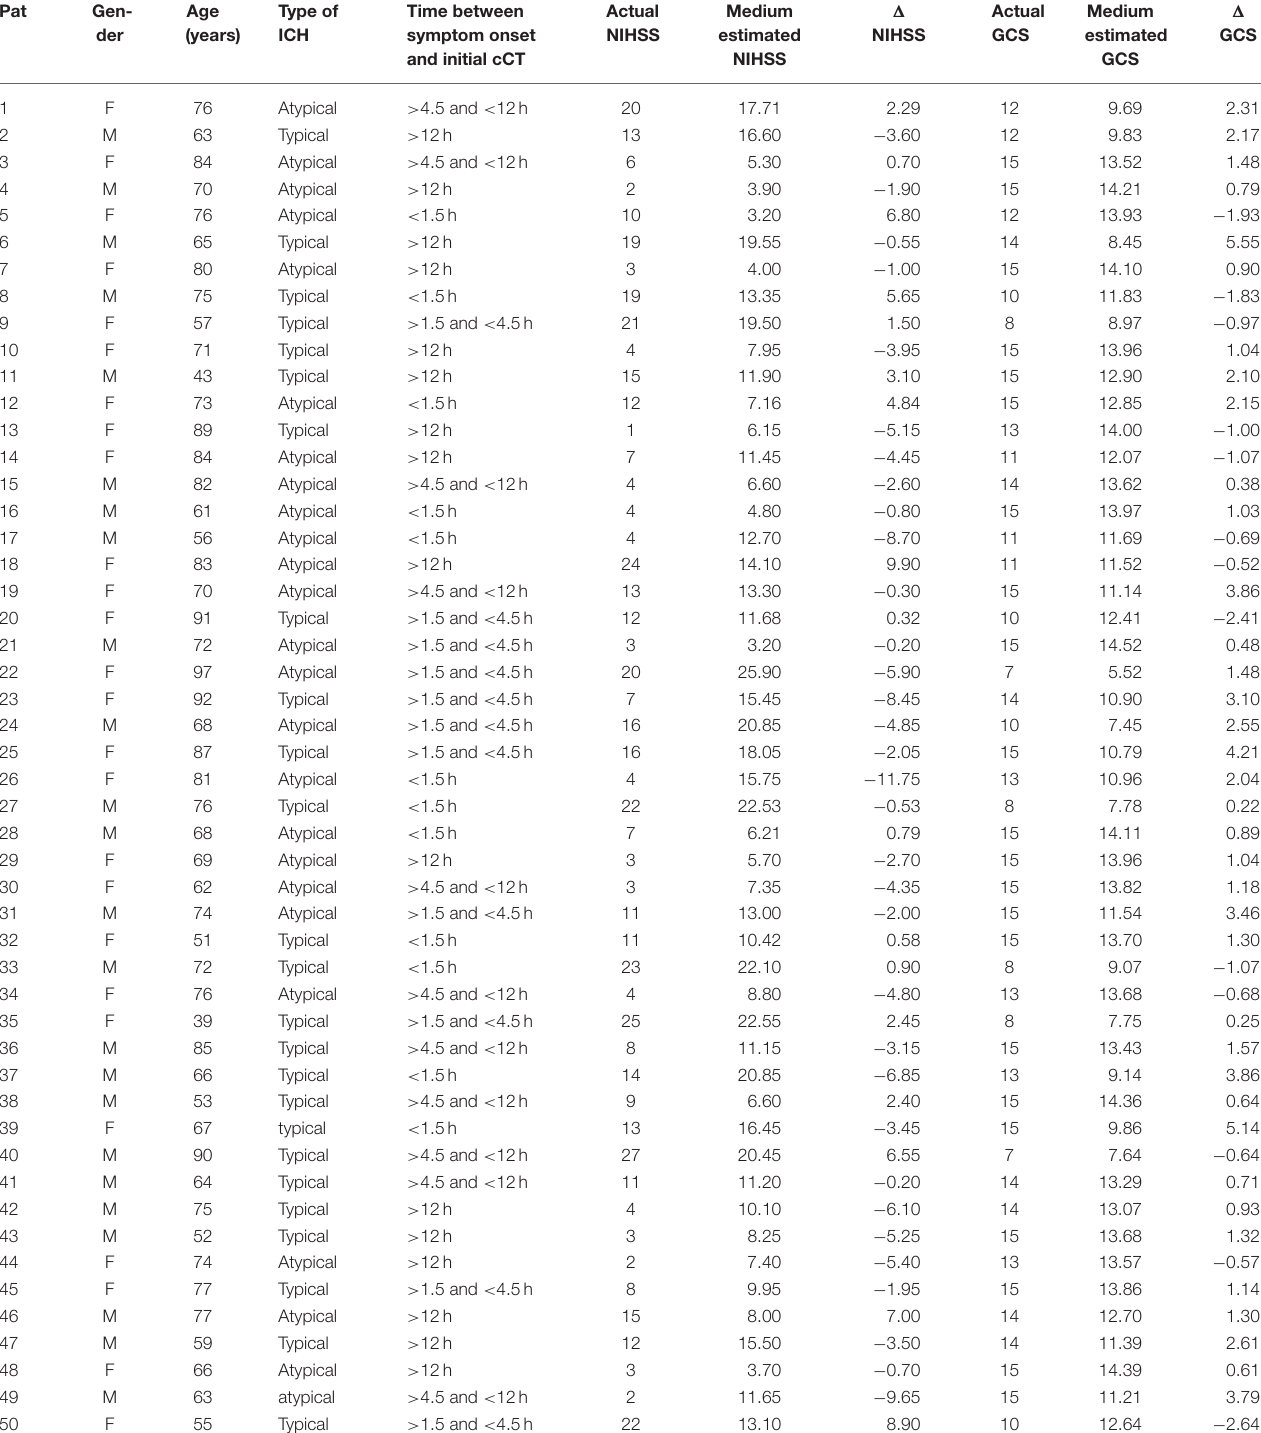
TABLE 1 | Patients characteristics: age, sex, time between symptom onset and initial cCT scan, actual GCS and NIHSS scores, medium GCS and NIHSS scores estimated by the neurologists or neurosurgeons on basis of the presented cCT scan and the basic information about the patient, delta GCS and NIHSS scores as the difference between the actual and the estimated GCS and NIHSS